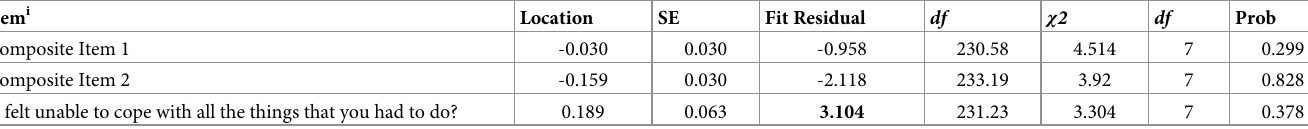
Table 3. The fit of the revised negatively worded items (“Perceived distress”) to the Rasch Model. Item i